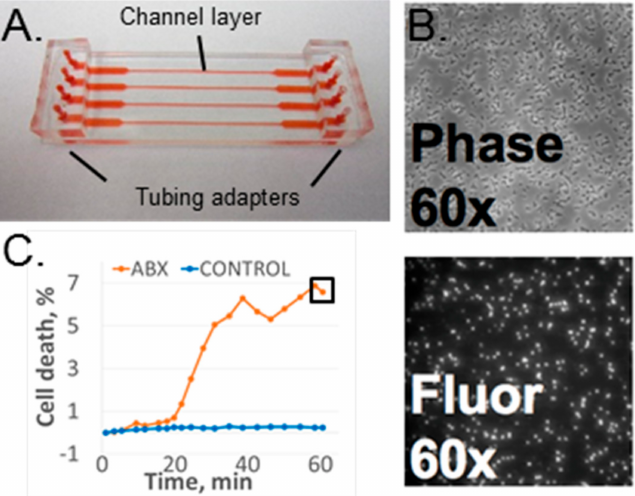
Figure 1. ( A ) Microfluidic antibiotic susceptibility testing (AST) device. Red shows filled channels. ( B ) Phase contrast and fluorescence images of susceptible S. aureus after 60 min of oxacillin exposure. ( C ) Data sample of time-dependent response for a susceptible strain with (ABX) and without antibiotic (control). The black square shows the 60-min time